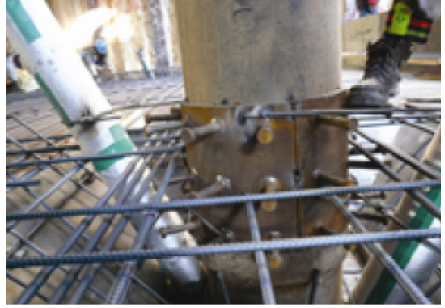
Fig. 12. Slab-column connections after slab bar